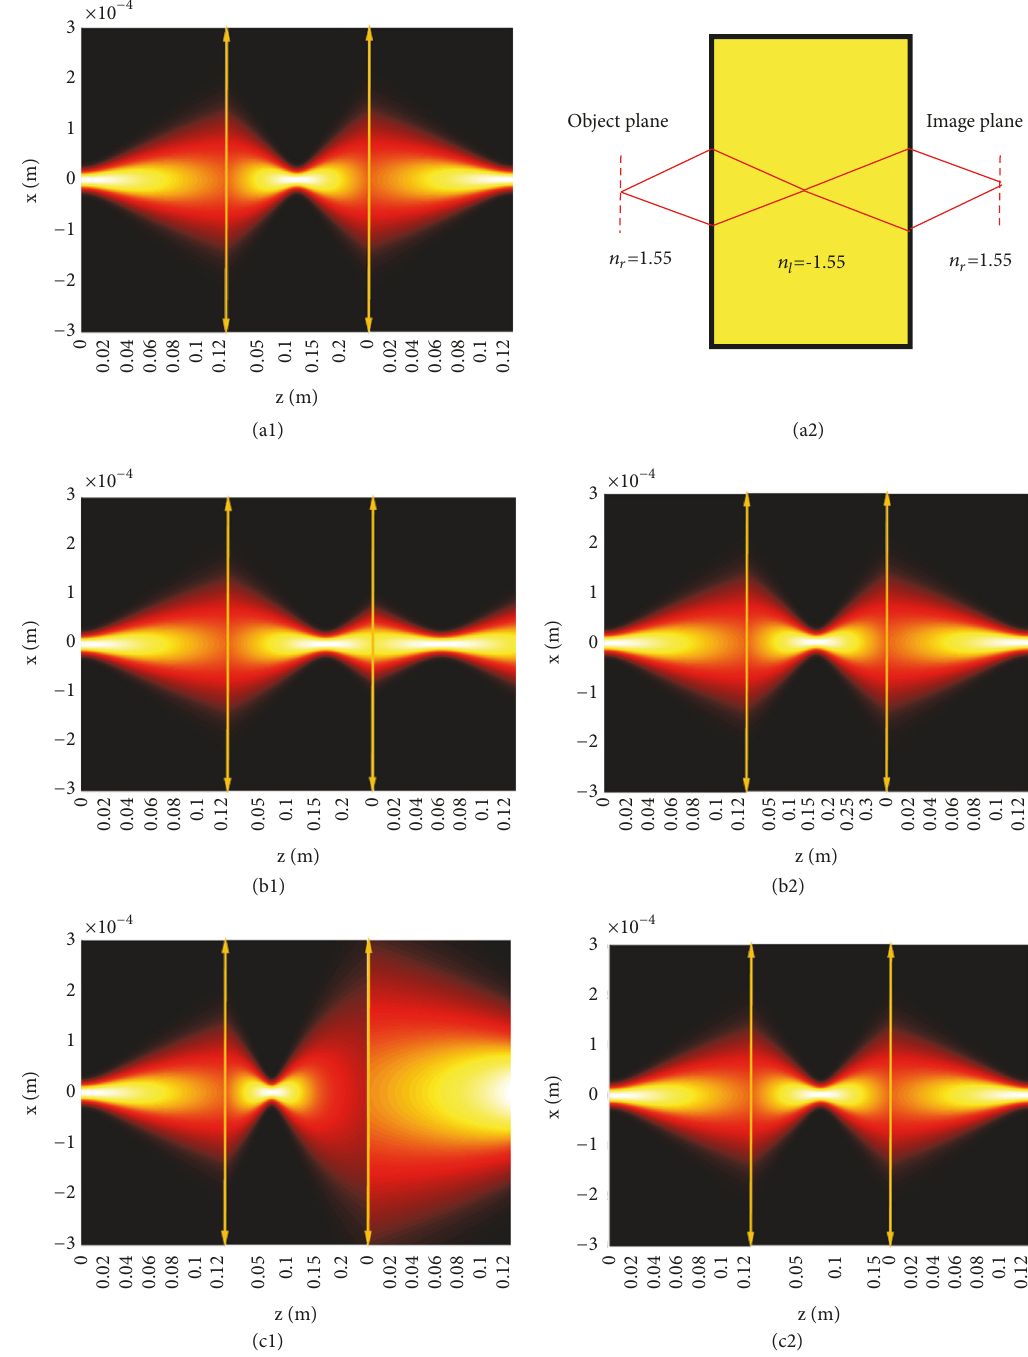
Figure 3: Side view of GB propagating in each RHM and DNM unit successively with three kinds of DNMs, 𝜔 0 =0.1 × 10 −3 m, 𝑛 𝑟 =1.55, 𝑍 𝜆 =632.8nm fixed: (a1) DNM 𝜔 𝜔 2𝜋 ] ×√2.55 ; (a2) principle diagram of the emerging GB comes back to its original 𝑅 =4.9646cm, and 𝑝𝑒 = 𝑝𝑚 = feature; (b1) DNM 𝜔 𝑝𝑒 = 𝜔 𝑝𝑚 = 2𝜋 ] ×√3.1 ; (b2) beam transmission in sandwich slab system, 𝑅 =2.5 𝑍 𝑅 , 𝐿 =7.0 𝑍 𝑅 , (c1) DNM 𝜔 𝑝𝑒 = 𝜔 𝑝𝑚 = 2𝜋 ] ×√2 and (c2) beam transmission in sandwich slab system, 𝑅 =2.5 𝑍 𝑅 , 𝐿 =3.4 𝑍 𝑅